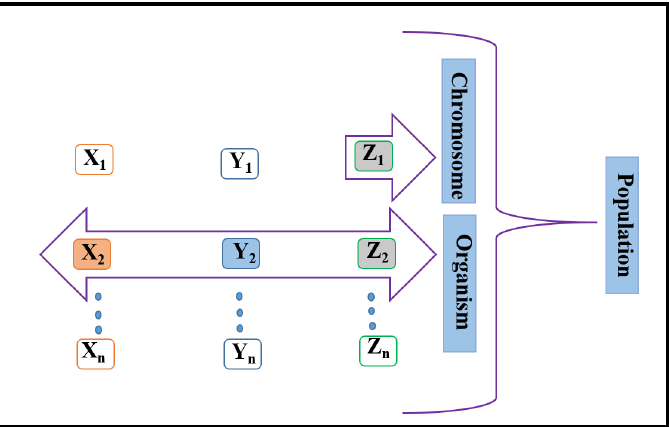
Figure 8. A simple diagram of the µ GA’s optimization factors.